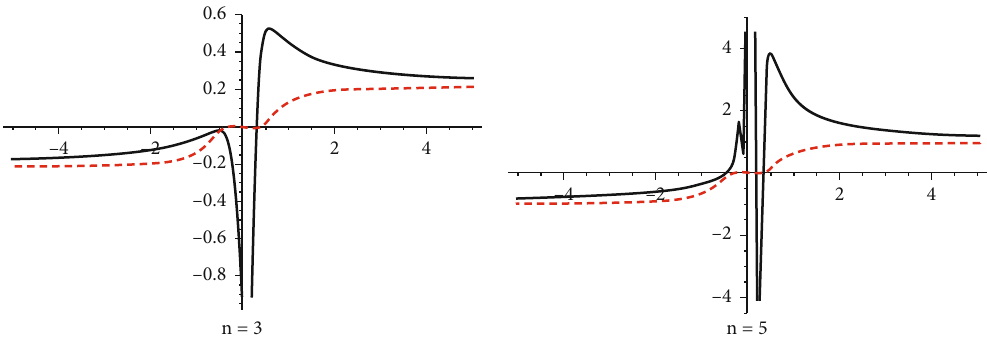
nz + 1 Þ for several values of n , whereas dashed lines represent the right-hand side of (12) with z ≡ x , both n ð − 1 where α = 0 : 2